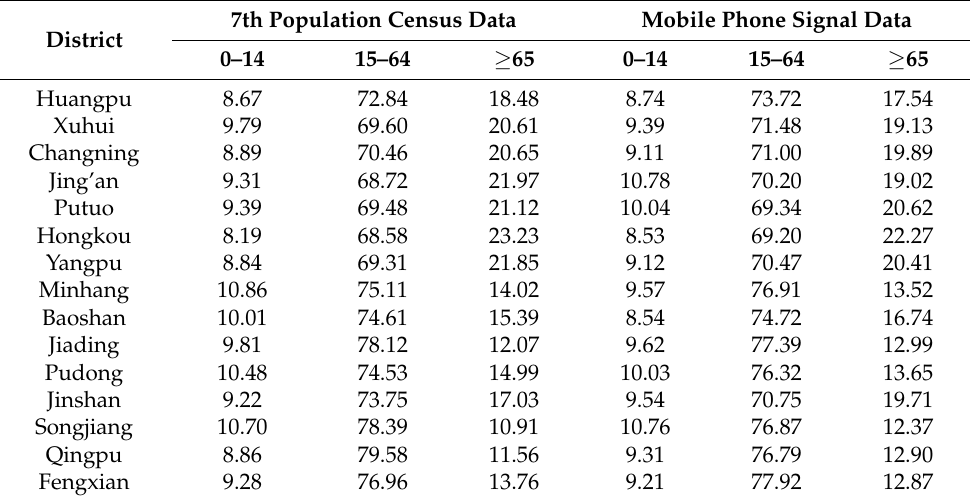
Table 4. Age structure in the districts of Shanghai